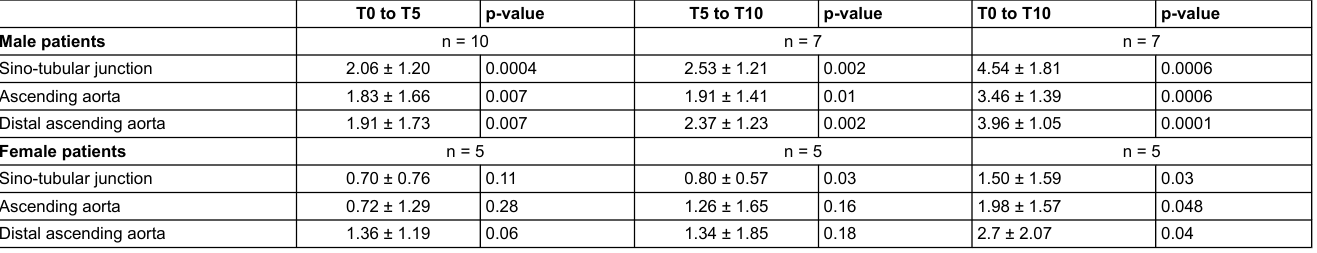
Table 2: Increase in measured aortic diameters in